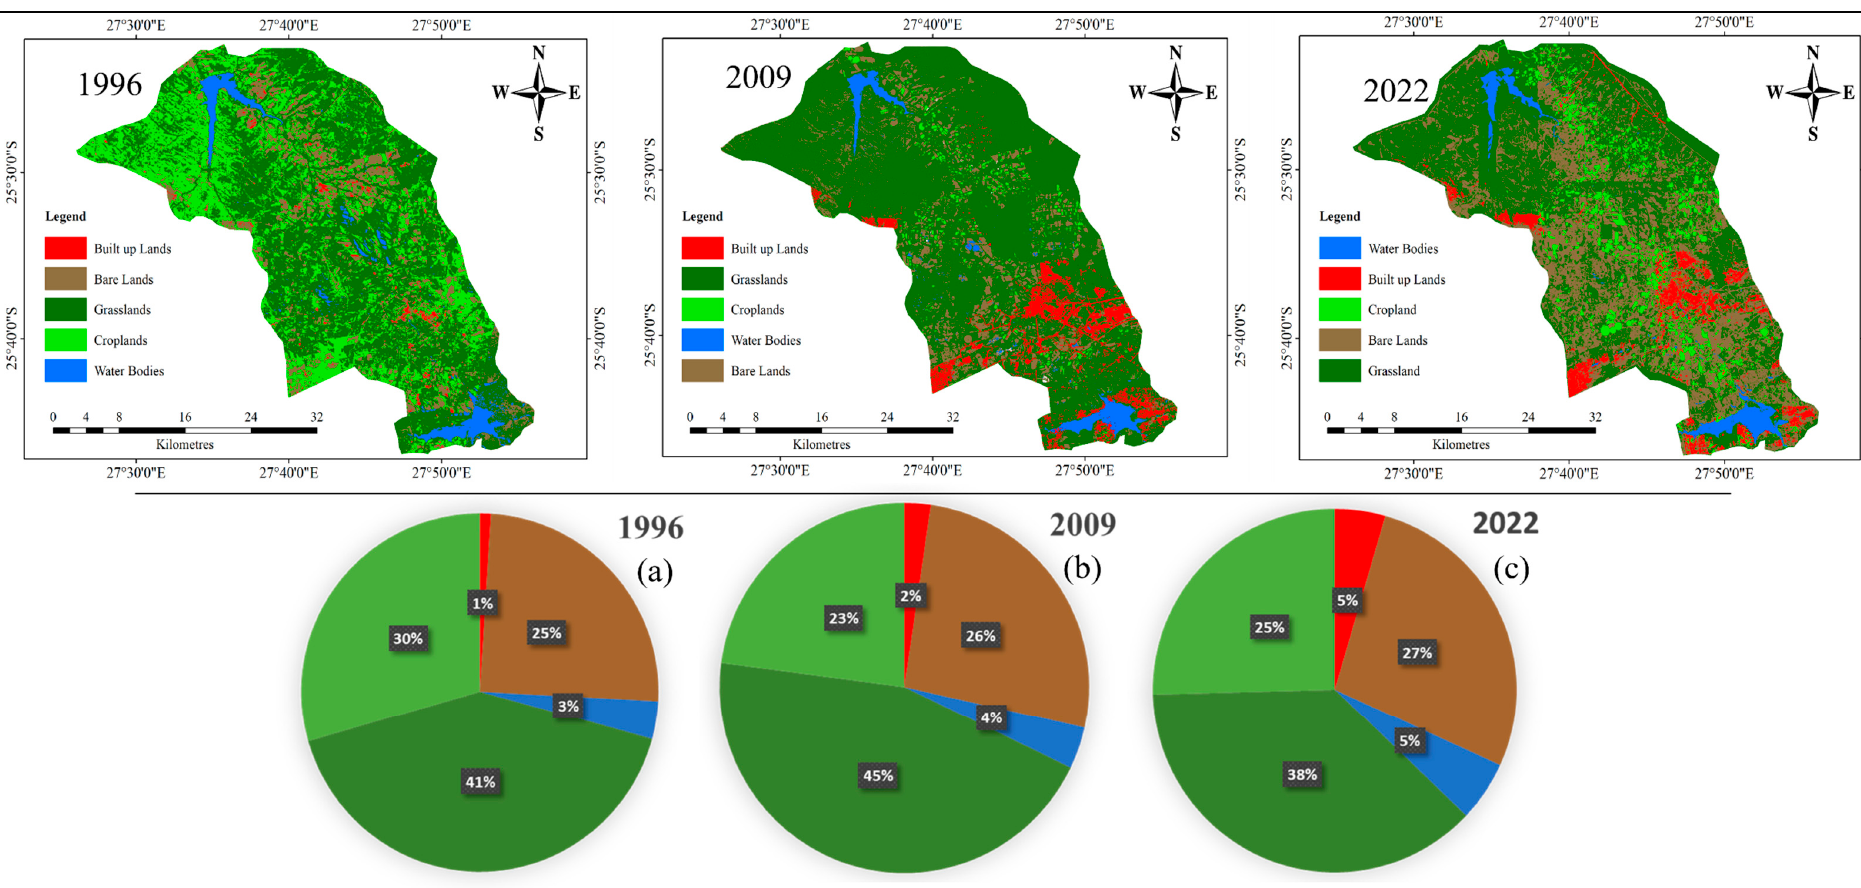
Figure 4. Land use distribution and percentage of areas of different land use types to the total basin areas in 1996 ( a ), 2009 ( b ) and 2022 ( c ).